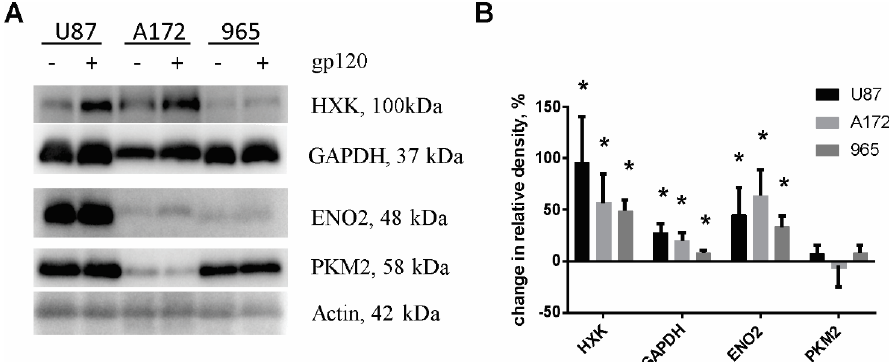
Figure 4. Gp120 upregulates expression of glycolytic enzymes in glioma cells. Western blot ( A ) and quantification of relative changes of glycolytic enzyme protein levels ( B ) for untreated and gp120-treated glioma cells. The bar graph shows the percent change in density of protein in gp120-treated relative to untreated cells. U87 and A172 cell lines and 965 primary glioma cells were investigated. β-actin was used as a loading control. The intensity of the chemiluminescent signal was corrected for minor changes in protein content after densitometry analysis of the India ink-stained membrane. Results are presented as mean ± S.D. with significant differences from control (*) ( p < 0.05). An unpaired t -test was used to determine the significance between gp120-treated and untreated groups. Five independent experiments ( n = 5) for each cell line were used for statistical analysis.